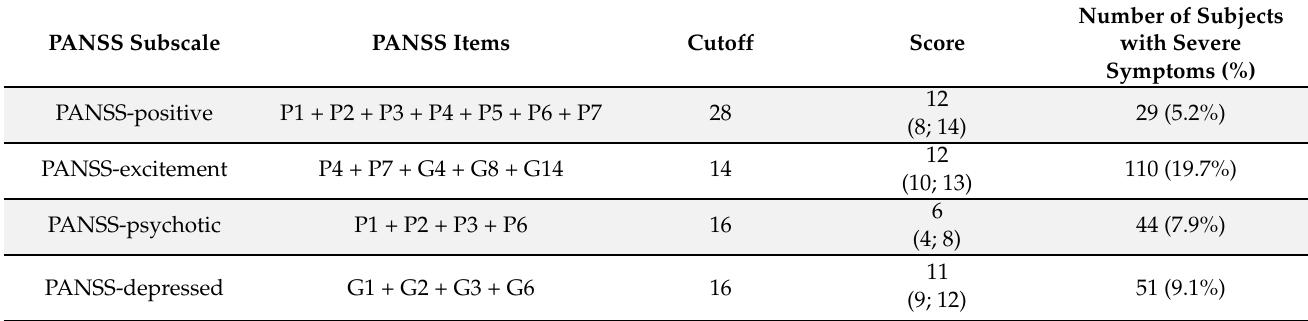
Table 2. PANSS scores of war veterans with PTSD according to different PANSS